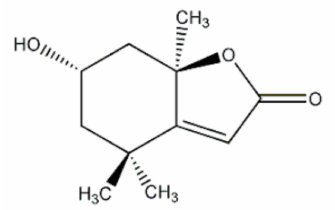
Figure 1. Structure of